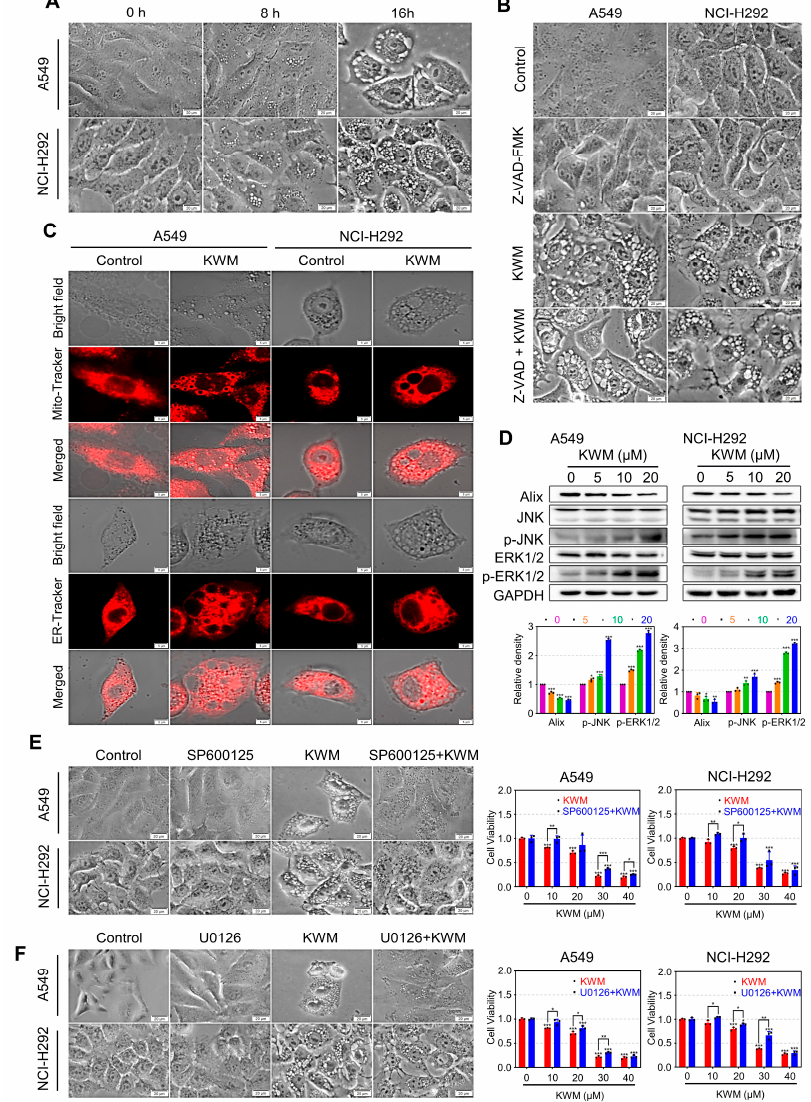
Figure 5. KWM-induced paraptosis in A549 and NCI-H292 cells. ( A ) A549 and NCI-H292 cells were treated with KWM (20 µ M), phase-contrast images were taken at indicated time points. ( B ) A549 and NCI-H292 cells were pretreated for 2 h in the presence or absence of Z-VAD(OMe)-FMK (20 µ M) prior to addition of KWM (20 µ M) or DMSO. Phase-contrast images were captured after 24 h. ( C ) Cells were treated with 20 µ M KWM for 24 h, then incubated with 1 µ M ER-Tracker Red or 125 nm Mito-Tracker Red for 30 min at 37 °C. Phase-contrast and fluorescent images were captured by confocal microscope. ( D ) Cells were incubated with KWM for 16 h, cell lysates were subjected to immunoblotting for paraptosis associated proteins. ( E , F ) Cells were pretreated for 2 h in the presence or absence of SP600125 (10 µ M) or U0126 (10 µ M) prior to addition of KWM (20 µ M) or DMSO. Phase-contrast images were captured after 12 h of treatment. Cell viability was determined by MTT assay after 48 h. Results were from three separate experiments. Values were expressed as mean ± SD, n = 3. * p < 0.05, ** p < 0.01, and *** p < 0.001 versus respective control